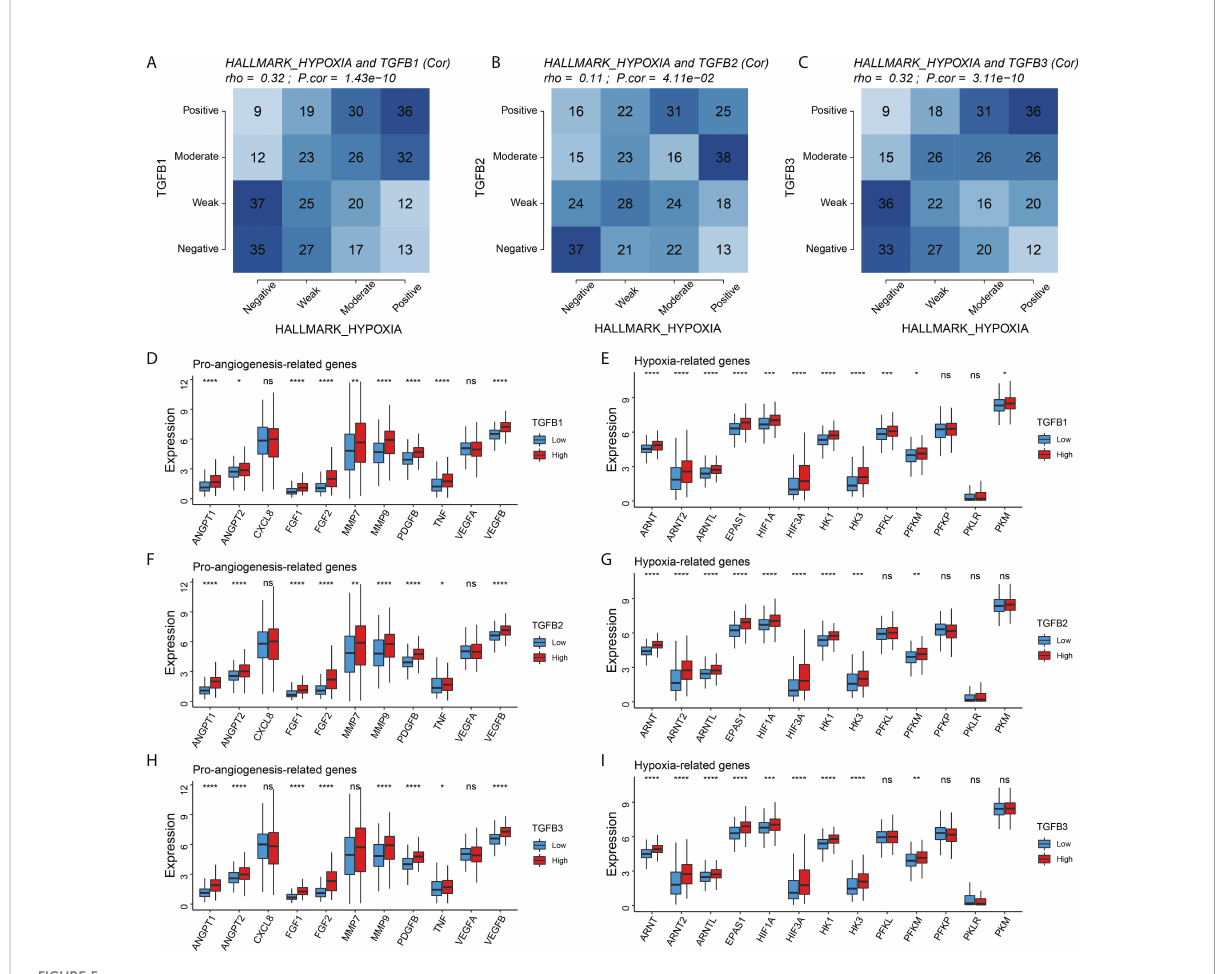
FIGURE 5 Correlation of TGF b with hypoxia. (A – C) Correlation analysis of TGF b 1, TGF b 2 and TGF b 3 with Hallmark hypoxia, respectively. Comparison of pro – angiogenesis – related genes and hypoxia – related genes among different TGF b 1 (D, E), TGF b 2 (F,G) , and TGF b 3 (H, I) subgroups. * P < 0.05; ** P < 0.01; *** P < 0.001; **** P < 0.0001. ns, no signi fi